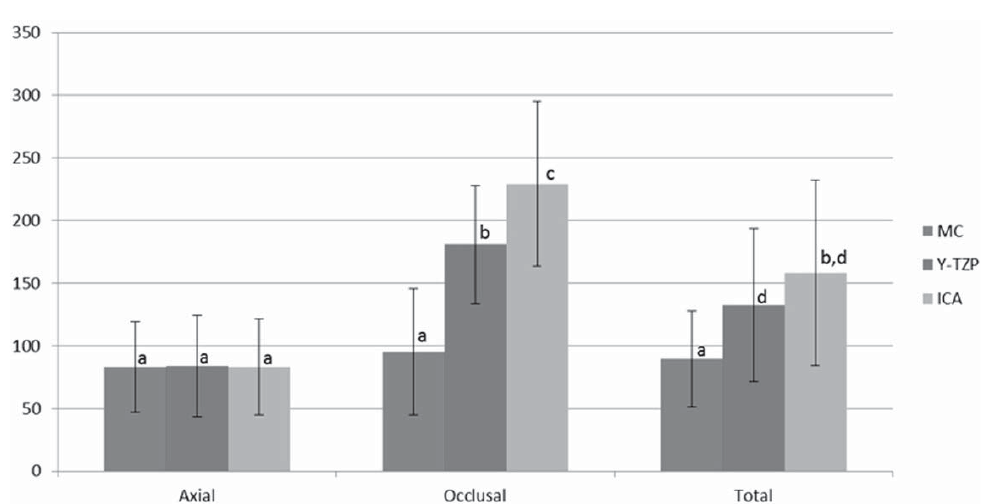
Figure 4 - (cid:2)(cid:3)(cid:4)(cid:5)(cid:6)(cid:7)(cid:4)(cid:5)(cid:8)(cid:7)(cid:6)(cid:9)(cid:4)(cid:5)(cid:8)(cid:4)(cid:10)(cid:8)(cid:7)(cid:8)(cid:3)(cid:11)(cid:12)(cid:4)(cid:9)(cid:12)(cid:13)(cid:5)(cid:6)(cid:7)(cid:13)(cid:14)(cid:7)(cid:9)(cid:15)(cid:3)(cid:7)(cid:12)(cid:5)(cid:9)(cid:3)(cid:10)(cid:5)(cid:4)(cid:16)(cid:7)(cid:17)(cid:9)(cid:7)(cid:18)(cid:19)(cid:7)(cid:20)(cid:10)(cid:13)(cid:21)(cid:22)(cid:6)(cid:7)(cid:23)(cid:24)(cid:25)(cid:26)(cid:27)(cid:7)(cid:28)(cid:4)(cid:16)(cid:21)(cid:3)(cid:6)(cid:7)(cid:29)(cid:12)(cid:9)(cid:15)(cid:7)(cid:9)(cid:15)(cid:3)(cid:7)(cid:6)(cid:4)(cid:25)(cid:3)(cid:7)(cid:16)(cid:3)(cid:9)(cid:9)(cid:3)(cid:10)(cid:7)(cid:29)(cid:3)(cid:10)(cid:3)(cid:7)(cid:5)(cid:13)(cid:9)(cid:7)(cid:6)(cid:12)(cid:20)(cid:5)(cid:12)(cid:17)(cid:30)(cid:4)(cid:5)(cid:9)(cid:16)(cid:19)(cid:7) (cid:8)(cid:12)(cid:14)(cid:14)(cid:3)(cid:10)(cid:3)(cid:5)(cid:9)(cid:7)(cid:23)(cid:22)(cid:31)!(cid:27)!"(cid:26)